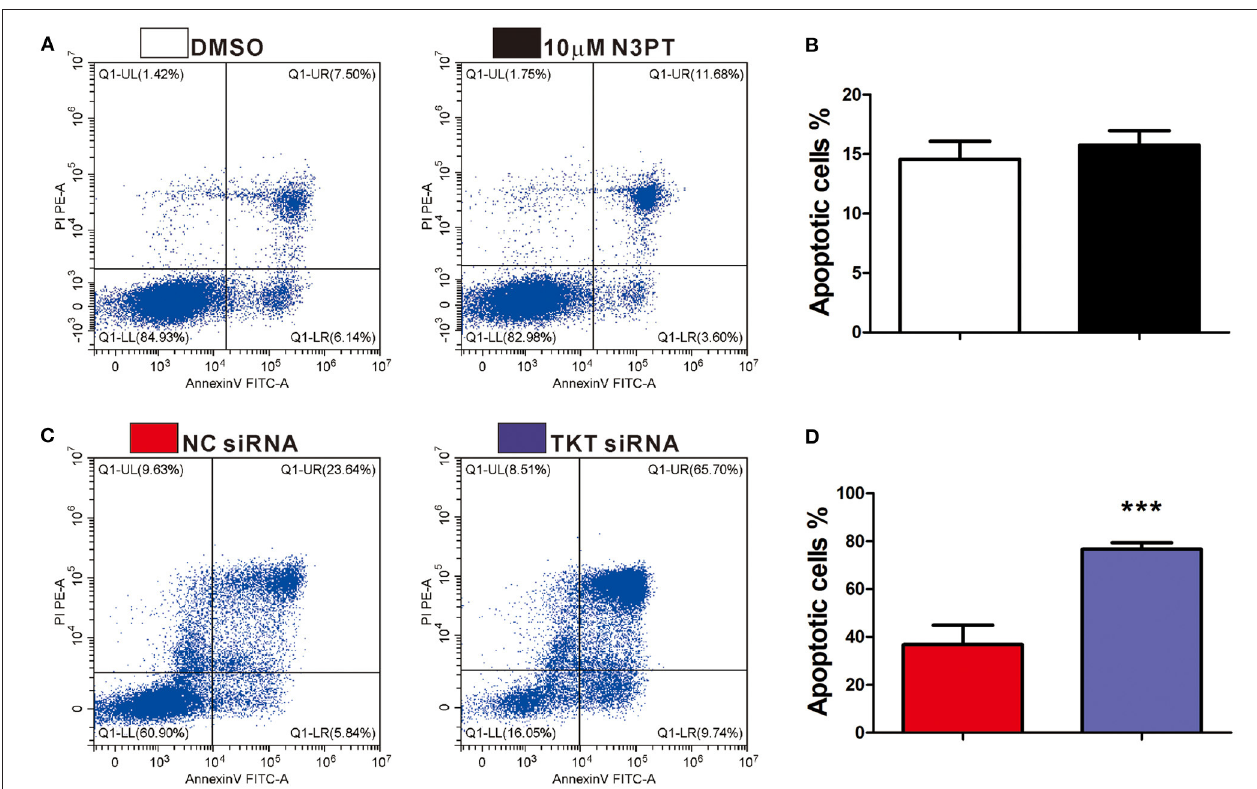
FIGURE 5 | Inhibition of TKT induces cell apoptosis. (A,B) HCT116 cells were treated with DMSO or the TKT inhibitor N3PT (10 µ M) for 24h. Cell apoptosis was assayed by co-staining with Annexin V/PI. There is no significant difference in the apoptotic cell ratio between the 10 uM N3PT treated group and the control group. (C,D) HCT116 cells were transfected with TKT siRNA or negative control (NC siRNA) for 72h. Cell apoptosis was assayed by co-staining with Annexin V/PI. The number of both early apoptotic and late apoptotic cells was significantly increased in the TKT siRNA group (C) . The apoptotic cell ratio was also significantly increased in the TKT siRNA group compared with the NC siRNA group (D) . Apoptotic cells are presented as the mean ± SD of three independent experiments (lower left: live cells, lower right: early apoptotic cells, upper right: late apoptotic cells, upper left: dead cells). N = 3/group, *** P < 0.001 vs. the control